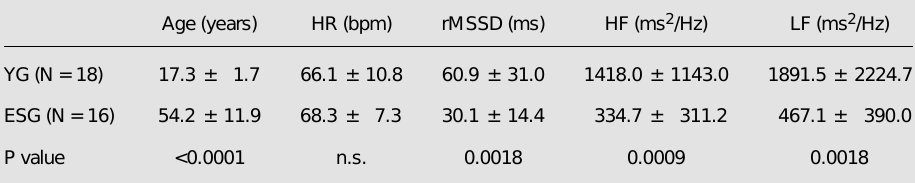
Table 1 - Mean values of age, HR and HRV indices (rMSSD, HF and LF) for YG and ESG. Values are reported as mean ± SD. All values but HR differed significantly between groups (see P values). n.s., Not significant. HR, Heart rate; HRV, heart rate variability; rMSSD, square root of the mean of the sum of squares of successive differences between adjacent normal-to-normal intervals; HF, high frequency band; LF, low frequency band; YG, young group; ESG, elderly sedentary group.